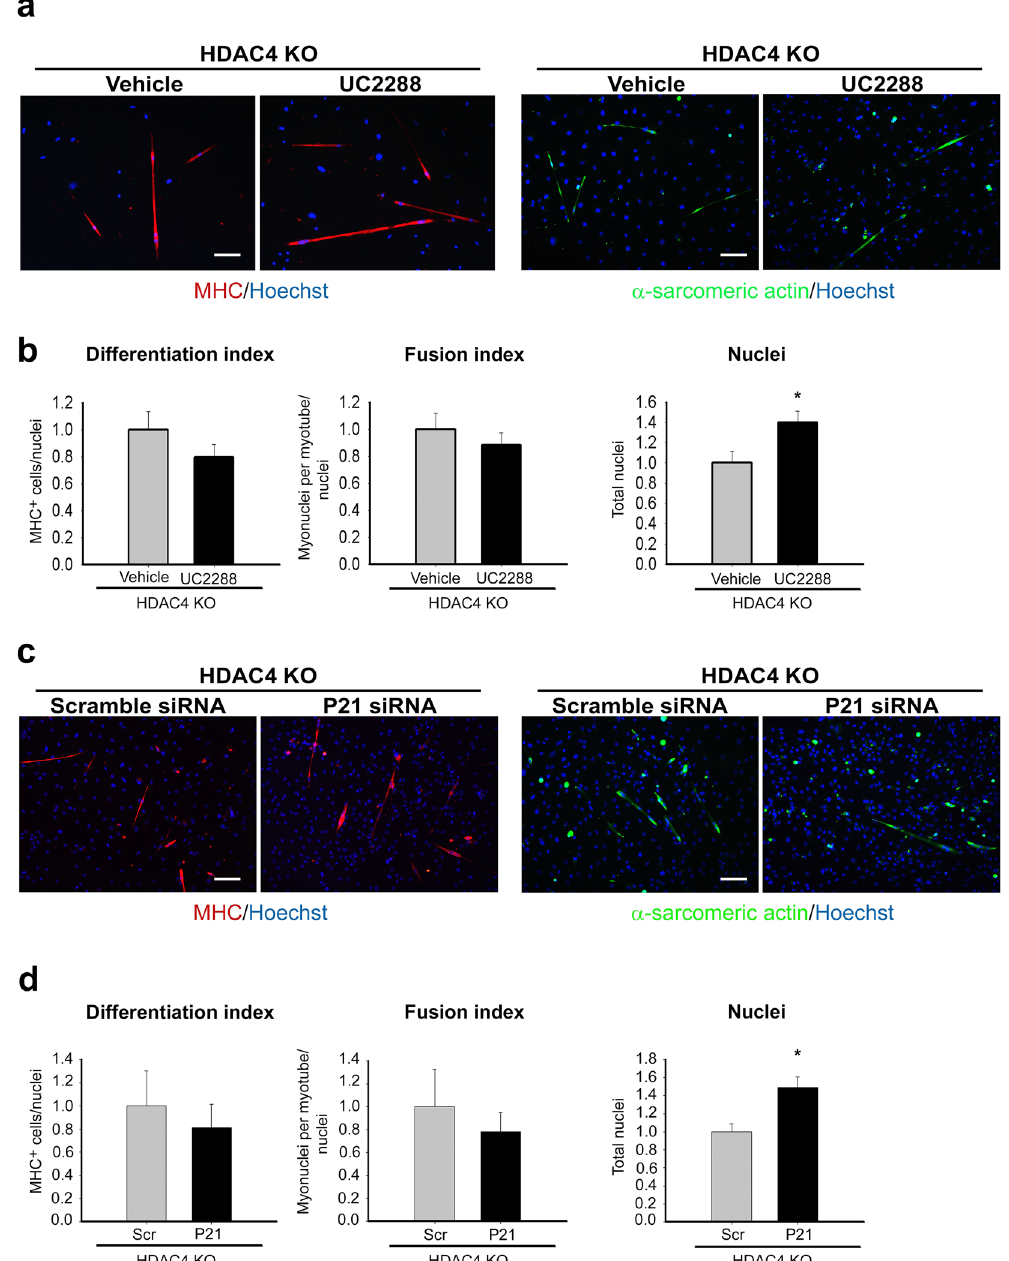
Figure 6. P21 is a HDAC4 target gene responsible for satellite cell proliferation. ( a ) Immunofluorescence for MHC and α -sarcomeric actin in HDAC4 KO satellite cells treated with UC2288 or vehicle for 24 hours and differentiated for three days. Scale bar: 100 μ m. ( b ) Quantification of the differentiation and fusion indexes; counts of total nuclei relative to vehicle-treated samples. n = 4 per condition. Data are presented as mean ± SEM. * p < 0.05 (Student’s t-test). ( c ) Immunofluorescence for MHC and α -sarcomeric actin in HDAC4 KO satellite cells transfected with a pool of four siRNA against P21 (P21 siRNA) or a pool of non-targeting siRNA (Scramble siRNA), as control and differentiated for three days. Scale bar: 100 μ m. ( d ) Quantification of the differentiation and fusion indexes; counts of total nuclei relative to Scramble (Scr)-treated samples. n = 4 per condition. Data are presented as mean ± SEM. * p < 0.05 (Student’s